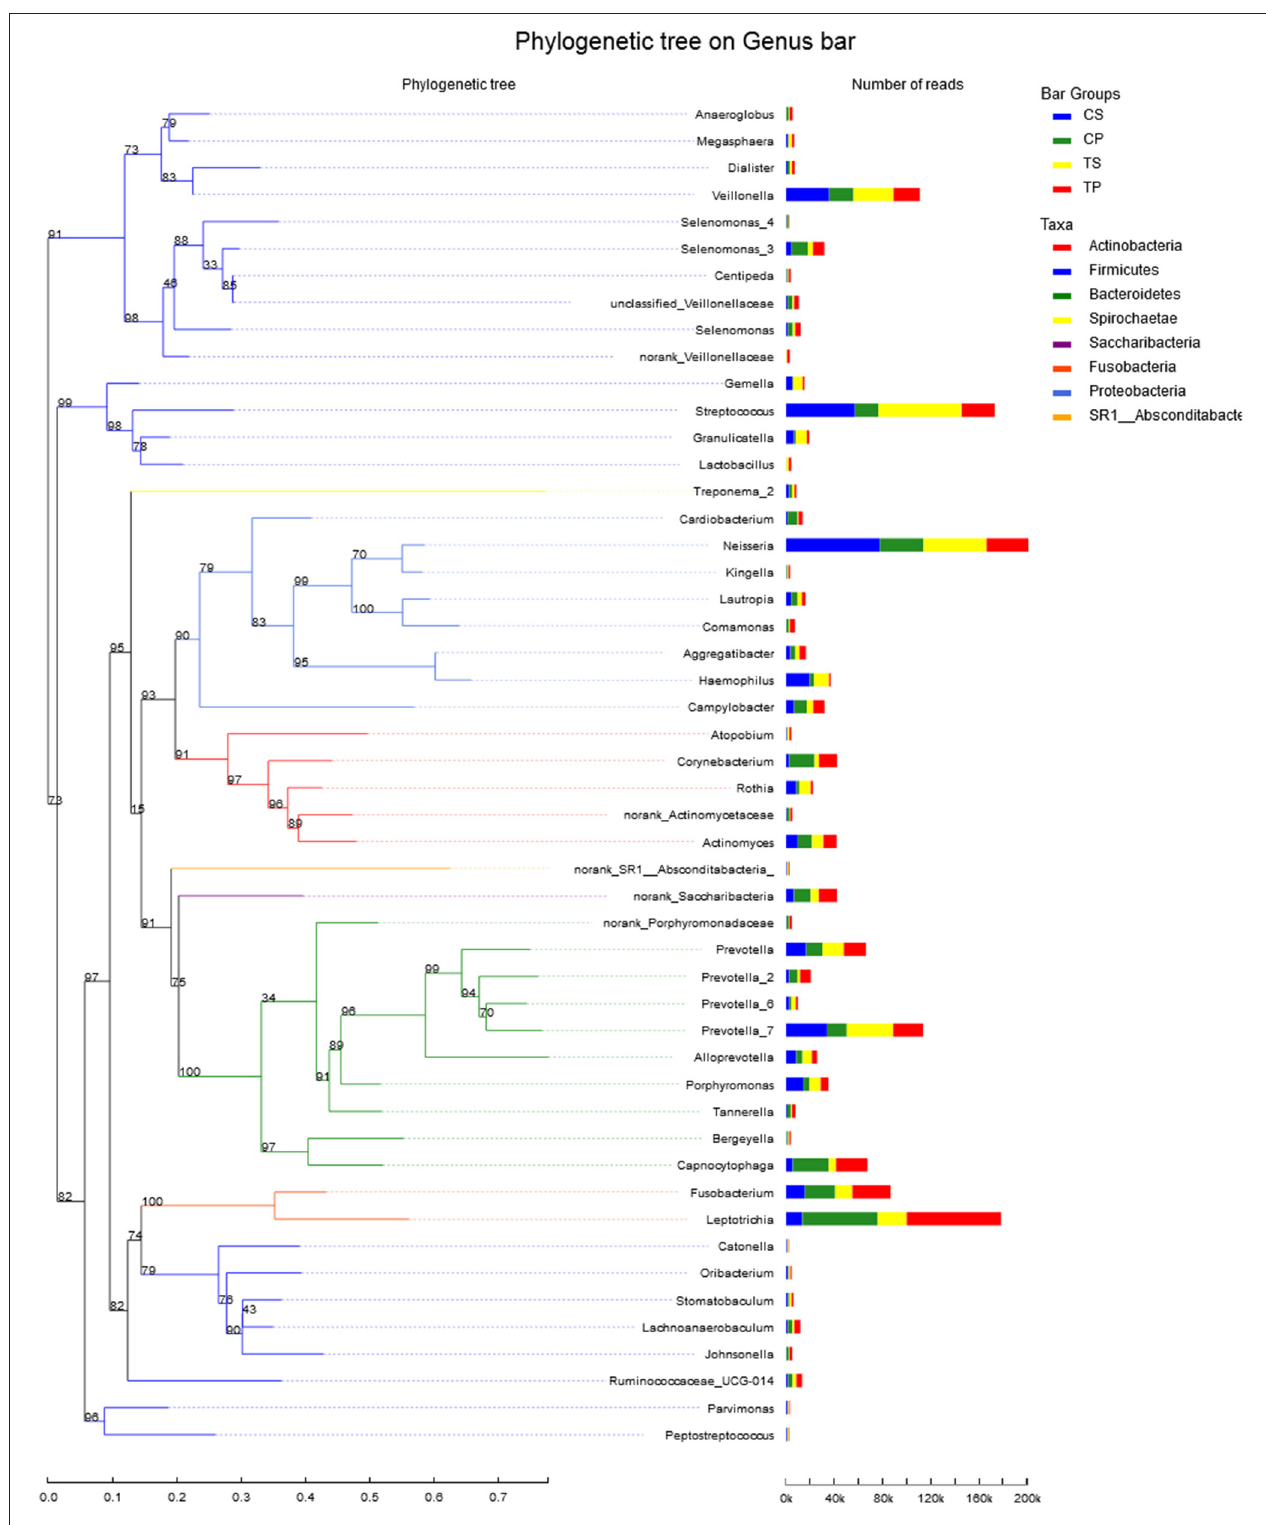
FIGURE 1 | The phylogenetic tree of the 50 most abundant genera. Each branch represents a taxon, the length shows phylogenic distances between two taxa, and different colors represent different phyla. The bar plot on the right side shows the relative abundance of each genus in four groups.